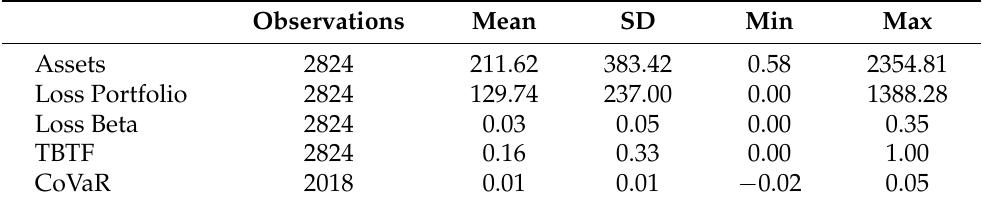
Table 4. Summary Statistics. This table reports summary statistics of bank assets, loss portfolios, loss beta, TBTF, and CoVaR. Bank assets are from Call Reports. Loss portfolio and loss beta following the models in Section 2 using Call Reports. TBTF is a dummy variable the equals one if the bank is identified as a TBTF bank based on the loss betas constructed. CoVaR is constructed following Adrian and Brunnermeier (2016). The sample is from the first quarter of 2002 to the second quarter of 2019 with U.S.banks with assets over $50 billion.